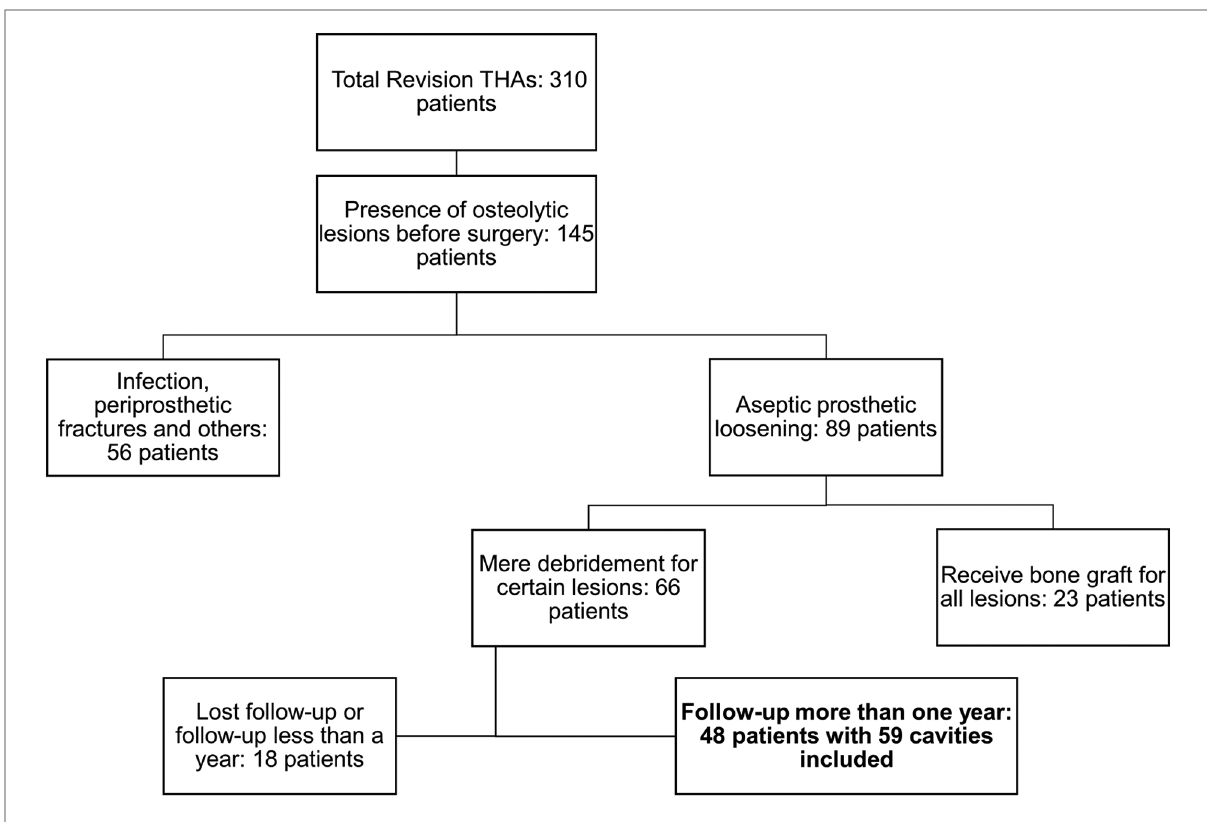
FIGURE 1 A fl owchart to illustrate our inclusion criteria and